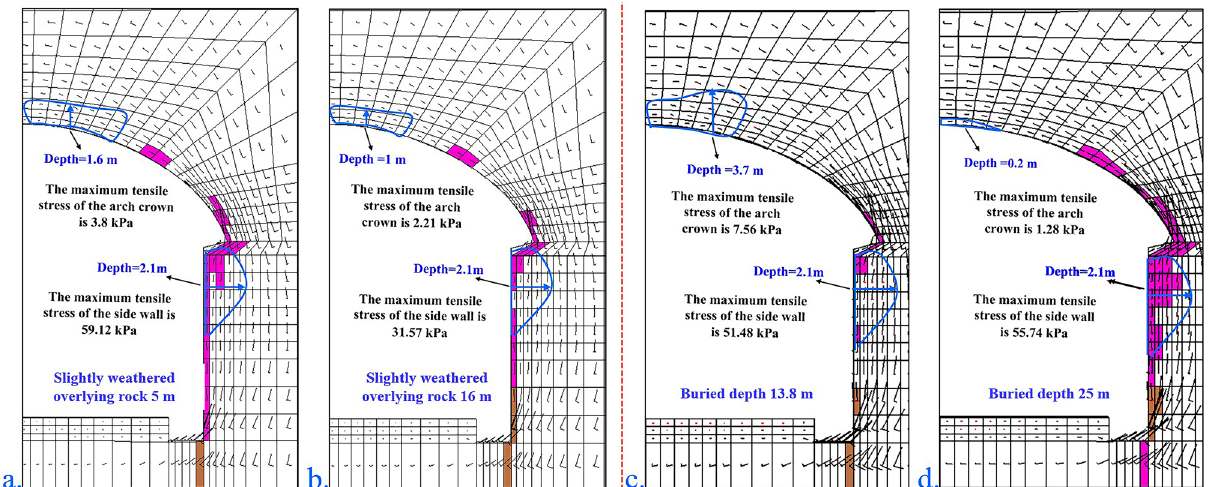
Figure 15. Principal stress vector diagram of the unsupported tunnel in level-IV1 surrounding rock under different working conditions. ( a ) slightly weathered overburden with a depth of 5 m; ( b ) slightly weathered overburden with a depth of 16 m; ( c ) buried depth of 13.8 m; ( d ) buried depth of 25